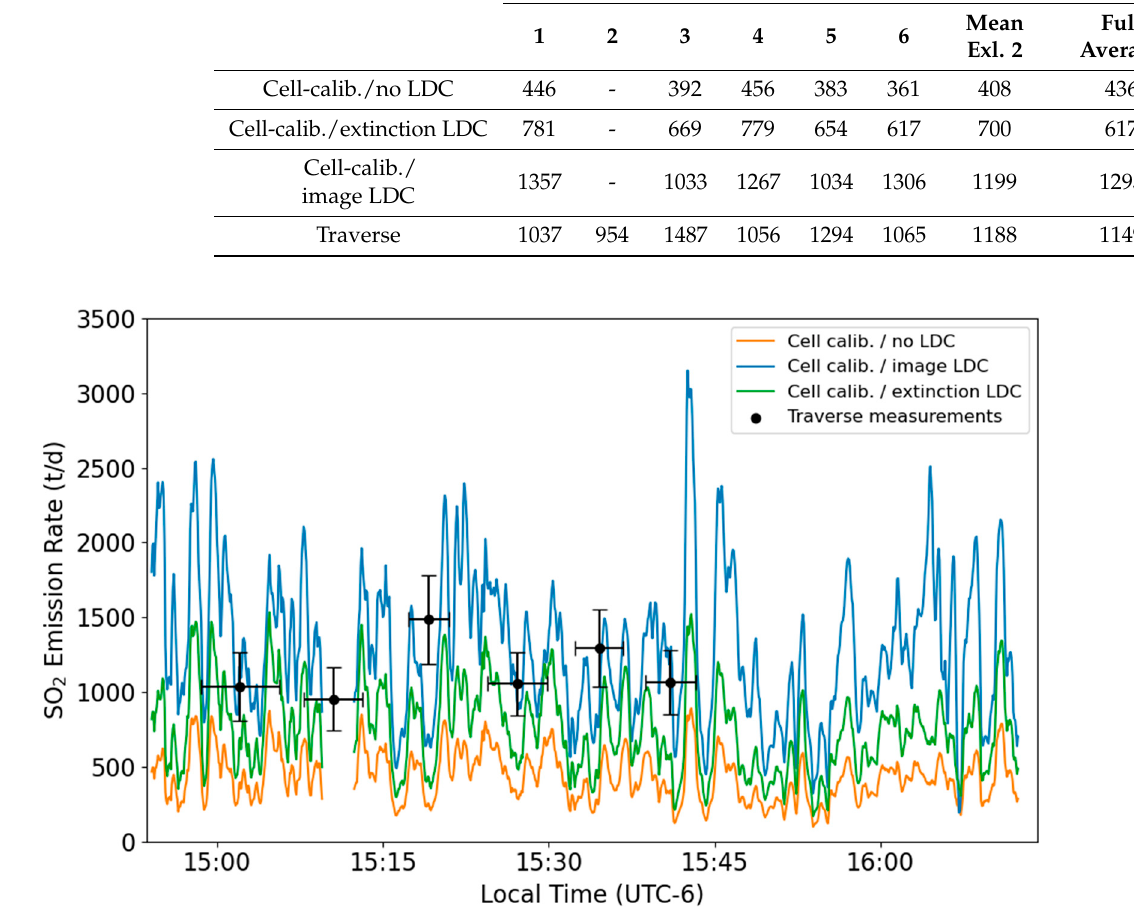
Figure 5. Uncorrected (orange), extinction (green) and image-based (blue) light dilution-corrected (LDC) SO 2 emission rate from 13 January 2018 as measured by the SO 2 camera, with using the cell calibration. Simultaneous traverse emission rates, shown in black, are plotted at the time measured at the center of mass of the traverse minus the travel time from SO 2 camera measurement line to traverse road. The traverse error accounts for the duration of the traverse and the error in plume speed estimate from the camera.